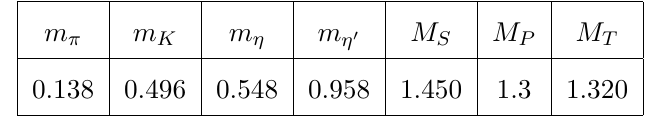
Table 16 . Masses (given in GeV) for the pseudoscalars and resonances.